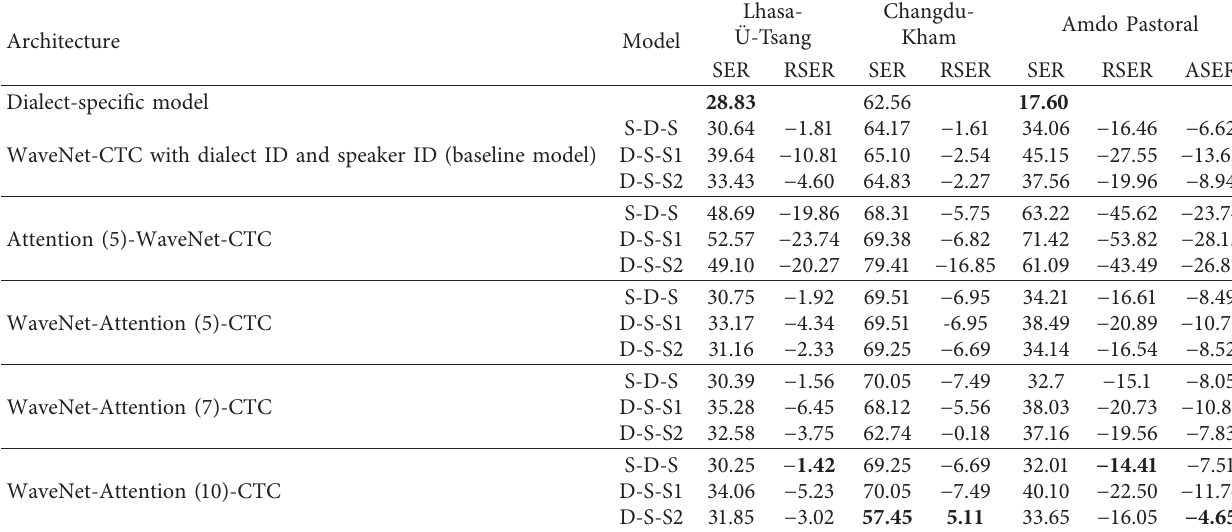
Table 5: Syllable error rate (%) of three-task models on speech content recognition.